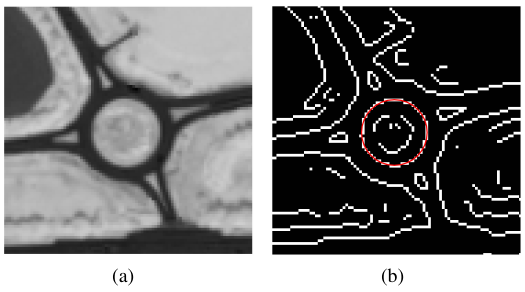
Figure 2: The NDVI image of a roundabout from the optical im- age (a) and the detected circle superimposed on the detected edge image (b). (a), the generated template (b) and the roundabout appearance in the SAR image (c).